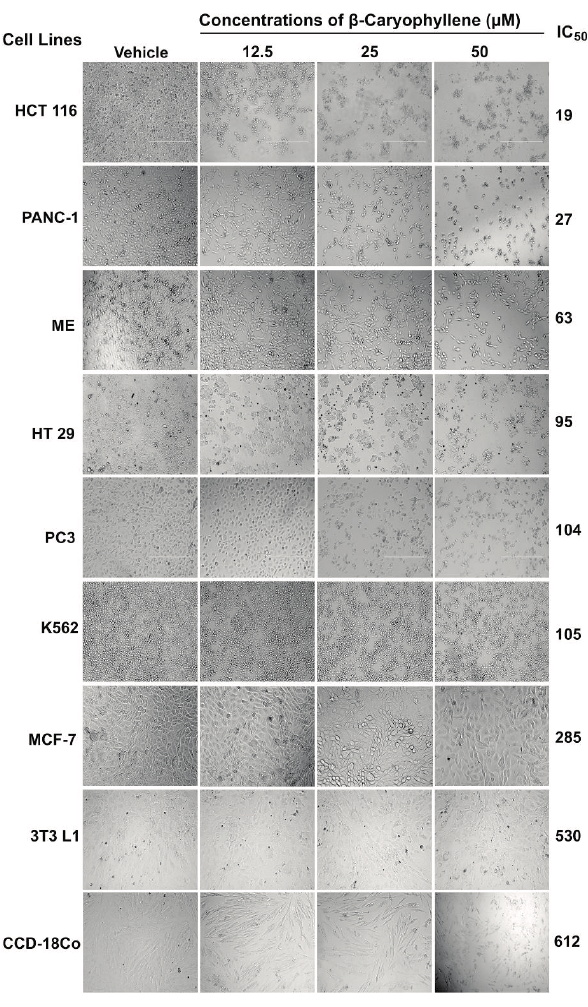
Figure 4. Effect of β -caryophyllene on the cellular morphology of human cancer and normal cell lines. Photomicrographic images of cancer cell lines, taken under an inverted phase-contrast microscope at 200× magnification using a digital camera at 48 h after treatment with β